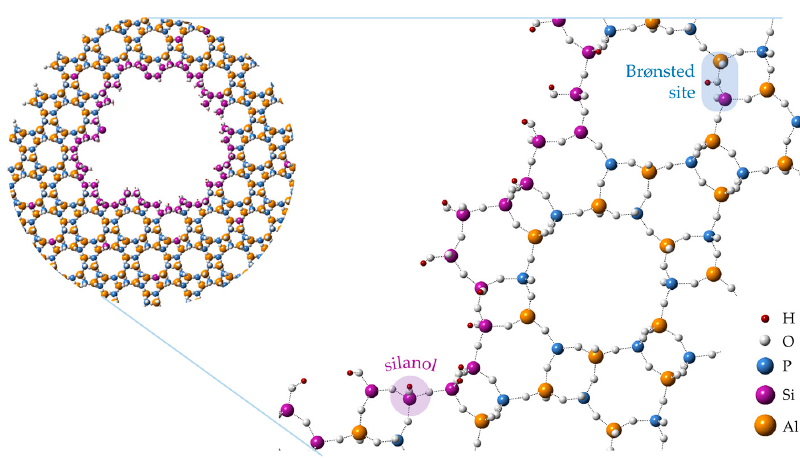
Figure 1. Depiction of hierarchical SAPO-5 prepared using an organosilane mesoporogen. The silanol sites are localised to the internal walls of the mesopore, whilst Brønsted acid sites are created in the bulk, microporous framework due to isomorphous substitution of silicon.